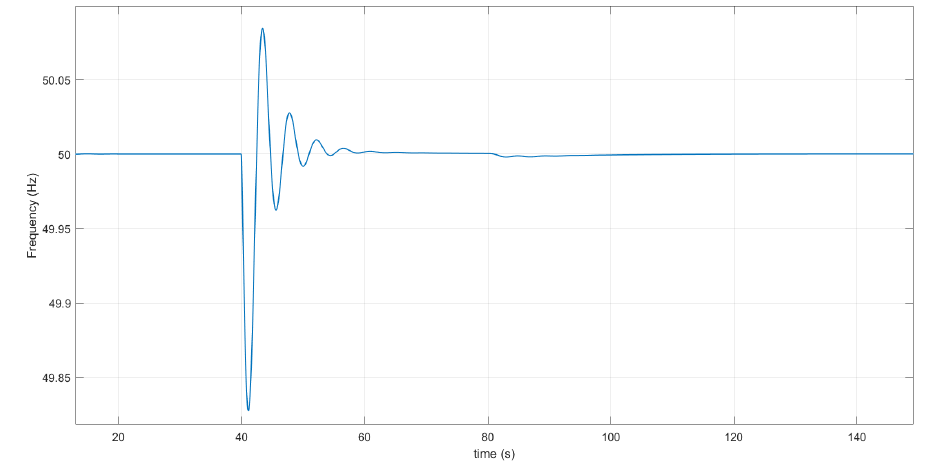
Figure 15. Frequency waveform in the area 2.